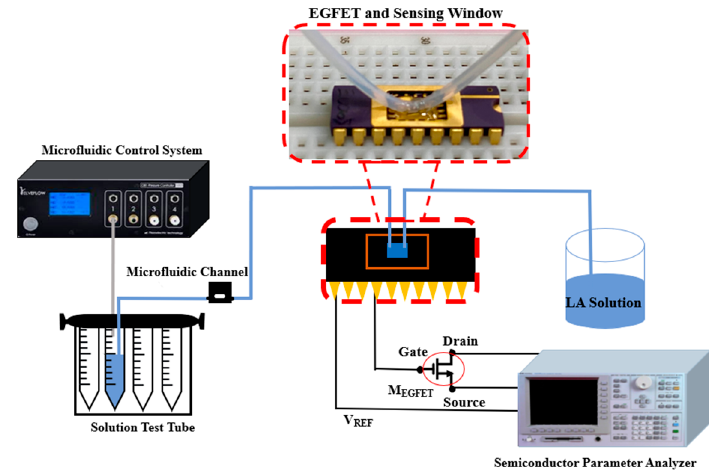
Figure 5. The microfluidic system combined with EGFET measurement.